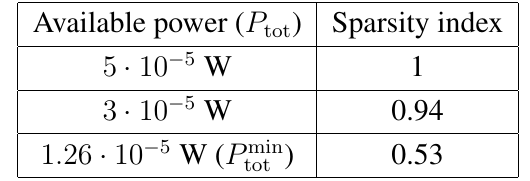
Table 5. Sparsity indexes of the adjacency matrix for the scenario presented in Figure 4a. Different values of overall network transmit power are